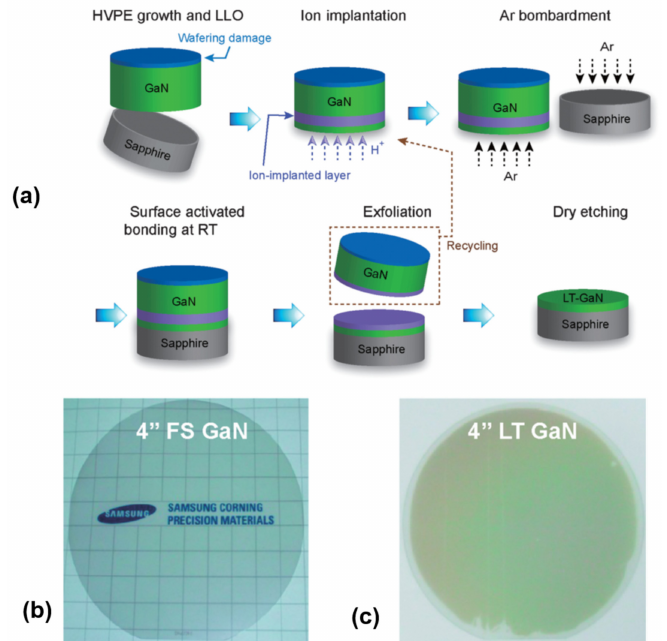
Figure 14. ( a ) Schematic illustrations of key steps for ion cutting techniques for GaN layer transfer. ( b ) Four-inch free-standing GaN template, and ( c ) transferred 4-inch GaN layer on the sapphire substrate. Adapted with permission from [2]. Copyright IOP Science,